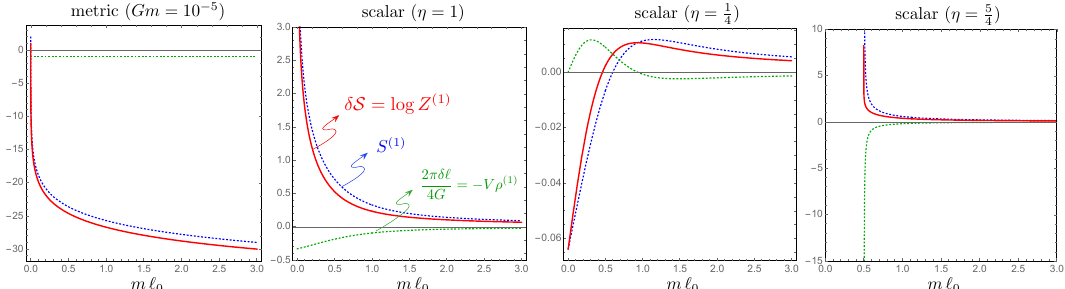
, i.e. , 5 4 4 ¯ ‘ = ‘ 0 + δ‘ , as dictated by 0 → √ η − 1 , the correction 0 → ‘ ∗ ≡ m